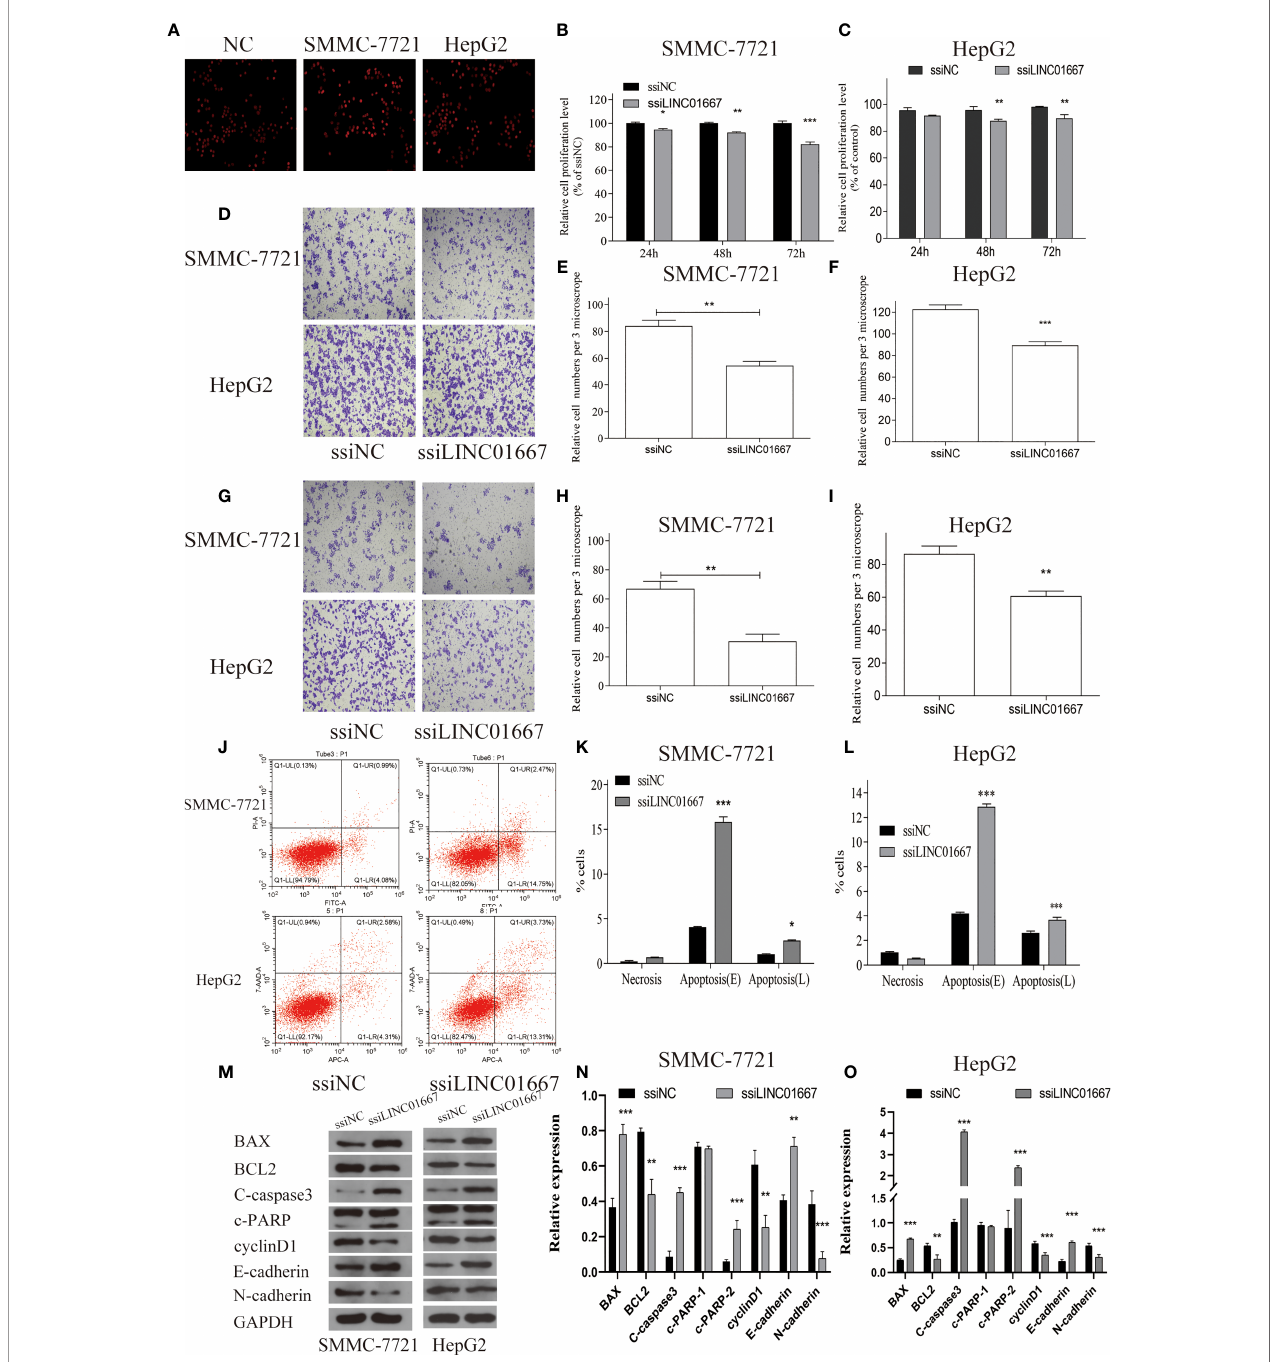
FIGURE 4 | Knockdown of LINC01667 inhibited cell proliferation, migration, and invasion, and promoted apoptosis in vitro . (A) EDU staining of different groups at 48h. (B, C) Proliferation potential in SMMC-7721 and HepG2 cell lines that inhibited of LINC01667 at 24, 48 and 72h. ** P <0.01, *** P < 0.001. (D) The transwell experiment was used to detect the migration potential of cells. (E, F) Migration potential in SMMC-7721 and HepG2 cell lines hat inhibited of LINC01667at 48h. ** P <0.01, *** P < 0.001. (G) The transwell experiment was used to detect the Invasion potential of cells. (H, I) Invasion potential in SMMC-7721 and HepG2 cell lines at 48h in LINC01667 knock downing cells. ** P <0.01, *** P < 0.001. (J) Flow cytometry experiments was used to detect the apoptosis potential. (K, L) LINC01667 knockdown increased cell apoptosis (*** P < 0.001). (M – O) Western blot was used to analysis the expression of BCL-2, cyclin D1, N-cadherin, Bax, C-caspase3, c-PARP2 and E- cadherin in HepG2/SMMC-7721 cells. * P <0.05. ** P <0.01, *** P < 0.001. ssiNC represents the random sequence group, and ssiLINC01667 represents the knockdown LINC01667